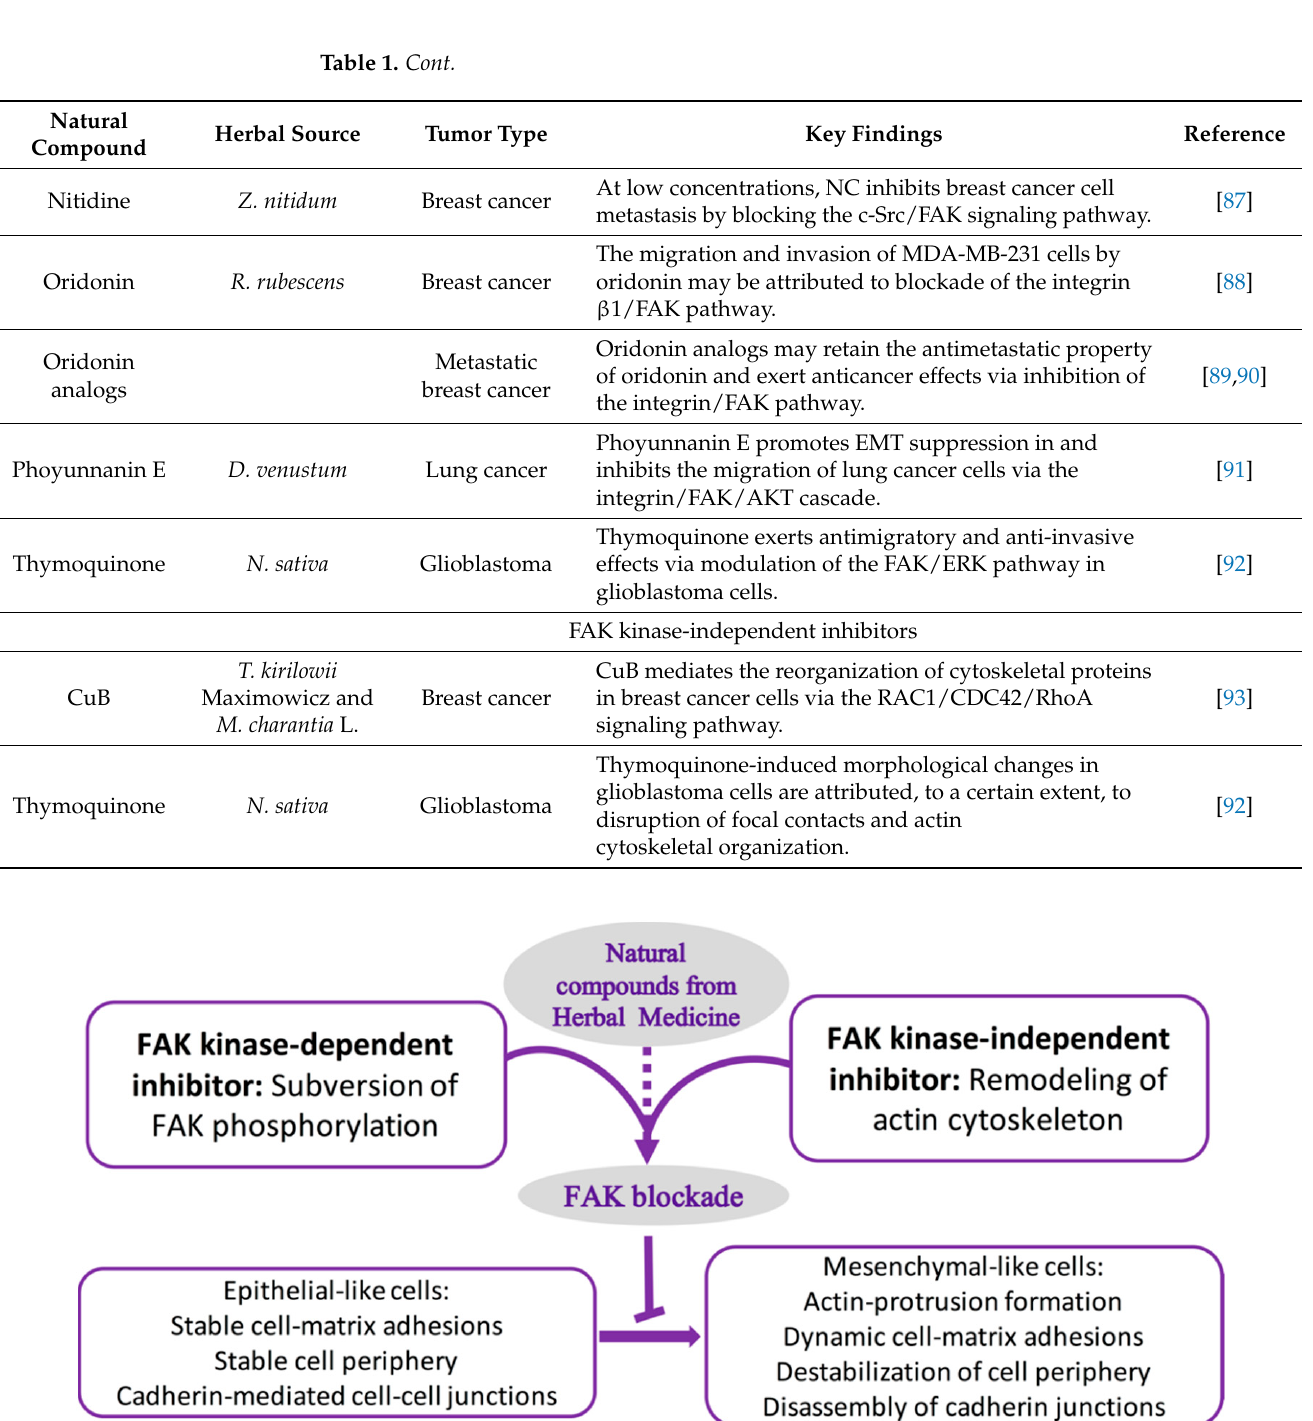
Figure 3. The natural compounds that potentially target FAK in cancer treatment. Natural compounds derived from Chinese herbal medicine can serve as FAK inhibitors and block the invasion and migration of cancer cells. Specifically, they can regulate cell motility, invasion, and survival in a kinase-dependent manner. Phosphorylation of FAK by Src modulates its localization and kinase activity, integrin- and E-cadherin-mediated adhesions, the formation of phosphorylation-dependent protein complexes, and cell movement and invasion. FAK also acts as a scaffold and participates in protein–protein interactions through its kinase-independent scaffolding function. These effects lead to EMT in cancer